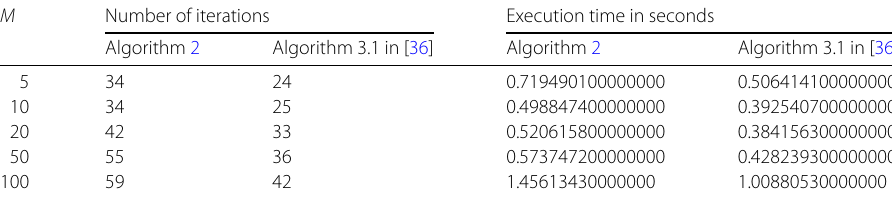
Table 1 Numerical data for Figs. 5, 6, 7, 8,